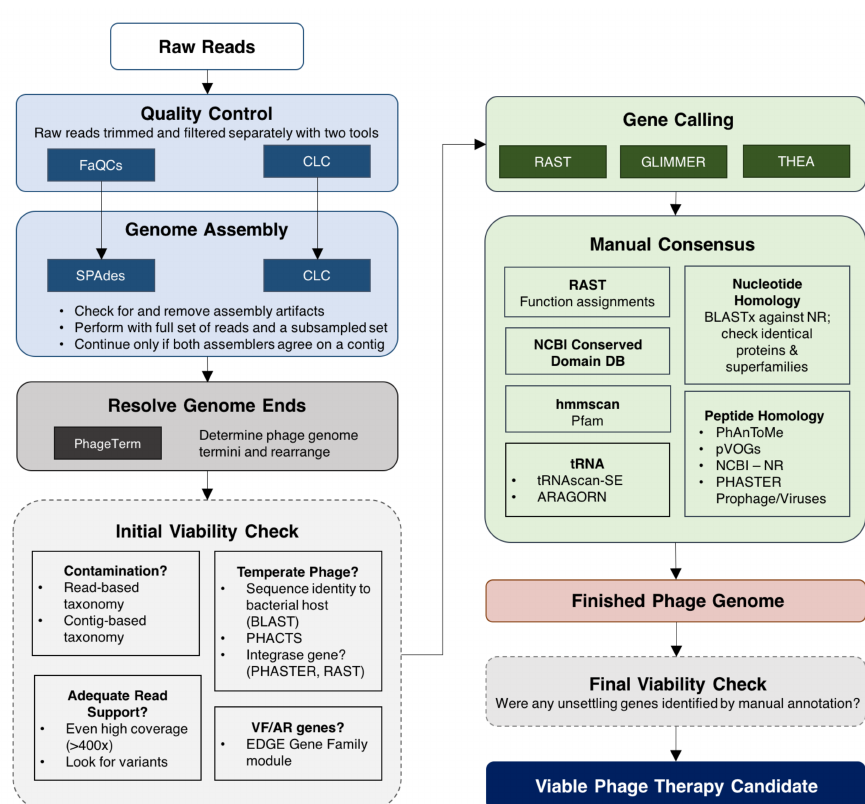
Figure 1. Phage characterization workflow. This pipeline is a simplified representation of tools and methods used to obtain high-quality phage genomes that are deemed viable phage therapy candidates. The pipeline begins with raw reads sequenced on an Illumina machine. To reduce potential bias introduced by bioinformatics tools, quality control and genome assembly are performed using two pipelines in parallel. The final genome sequence is obtained after resolving genome ends. Key viability checkpoints are outlined with dashed borders. In the initial viability check, phages are assessed for problematic genes (antimicrobial resistance (AMR), virulence factors (VF), toxins) and lifestyle. If a candidate passes the initial viability check, a combinatorial approach is applied to identify open reading frames followed by rigorous